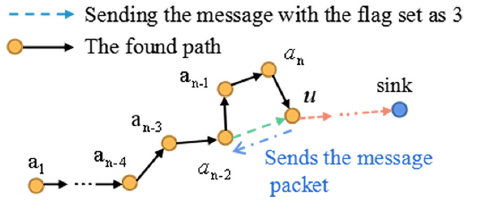
Figure 10. The current forwarder u finds that the ID of its 1-hop neighbor node a n − 2 is in the burst packet, which means a path-circle situation occurs in the found path. Then, node u informs node a n − 2 to transmit data to u directly through sending a message packet with the flag set as 3. Finally, node a n − 2 updates the routing table.